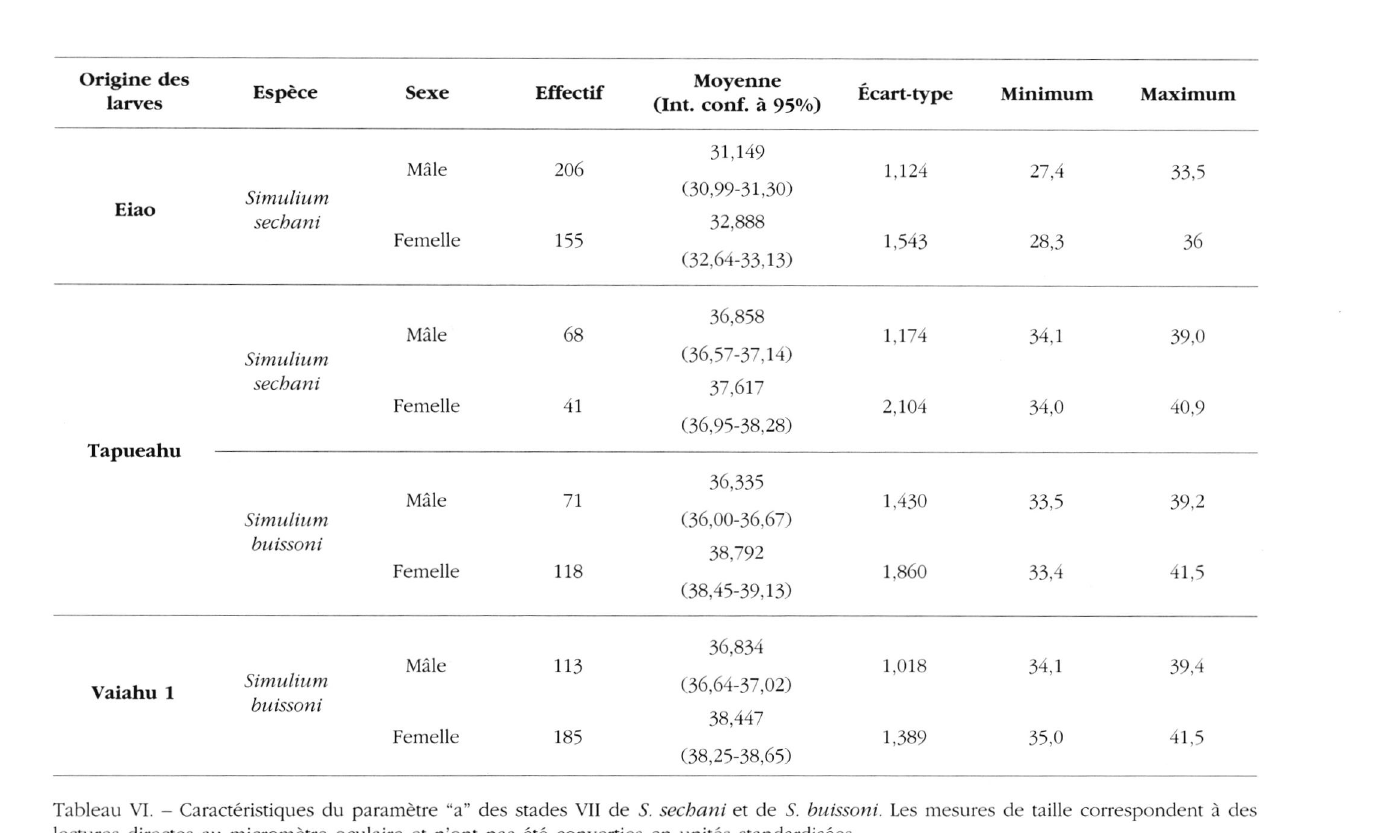
Tableau VI. - Caractéristiques du paramètre "a" des stades VII de S. sechani et de S. buissoni. Les mesures de taille correspondent à des lectures directes au micromètre oculaire et n'ont pas été converties en unités standardisées